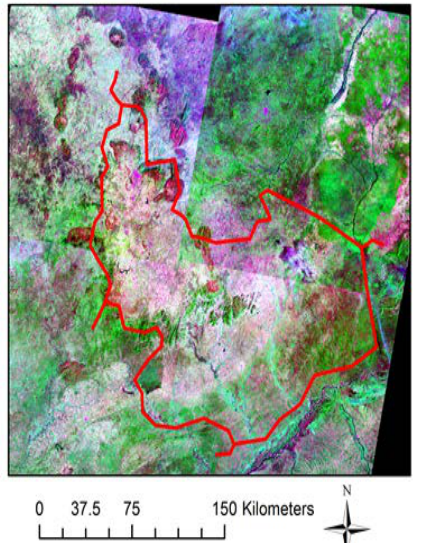
Figure 4. Mosaicked Composites of four scenes and